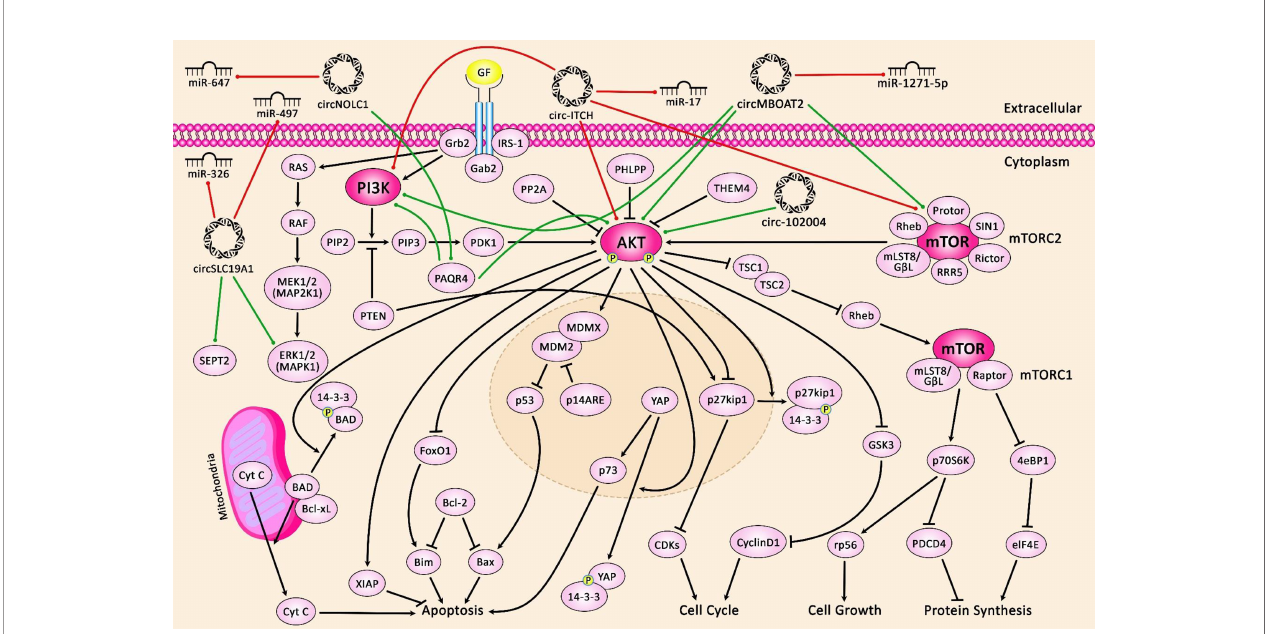
FIGURE 1 | A schematic diagram of the crosstalk between circRNAs and PI3K/AKT/mTOR and MAPK/ERK signaling pathways in prostate cancer. The fi gure suggests that extracellular circRNAs enter